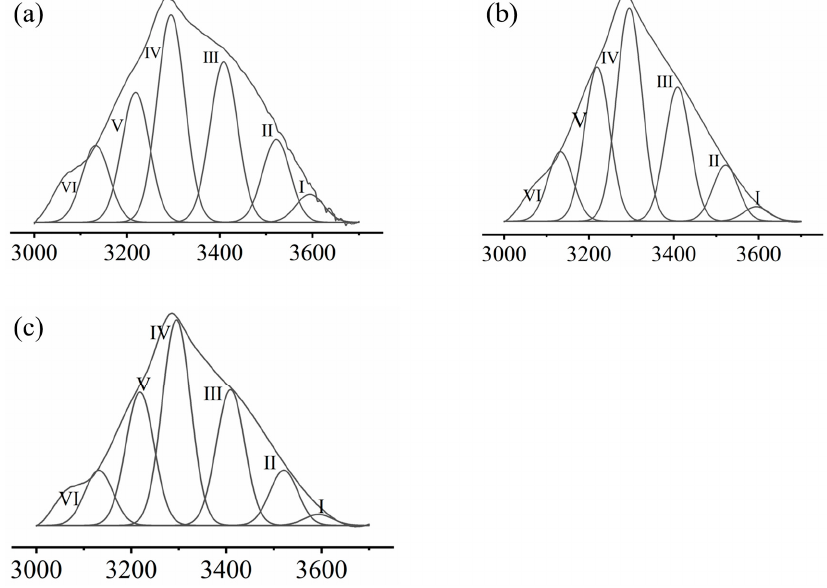
Figure 2. Gauss curve fitting of FTIR spectra of different samples, ( a ) MP, ( b ) MP + trehalose, and ( c ) MP + COS by different types of hydrogen bonds. Roman number I–VI is the serial number of sub-peaks corresponding to the hydrogen bond types in Table